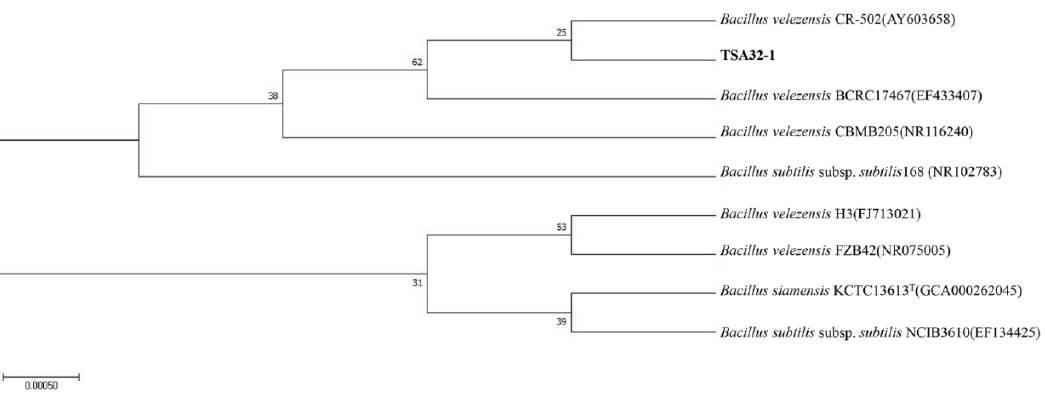
Figure 1. 16S rRNA phylogenetic analysis of selected strain. Phylogenetic tree based on maximum likelihood method of 16S rRNA gene sequences of TSA32-1. The tree was created using the maximum likelihood method and numbers at the branch points are bootstrap values (based on 500 samplings expressed in percentages).